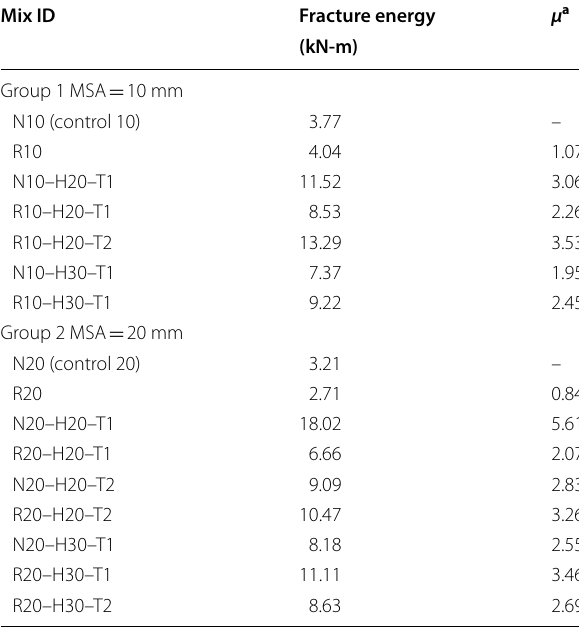
Table 7 Fracture energy of all mixes.